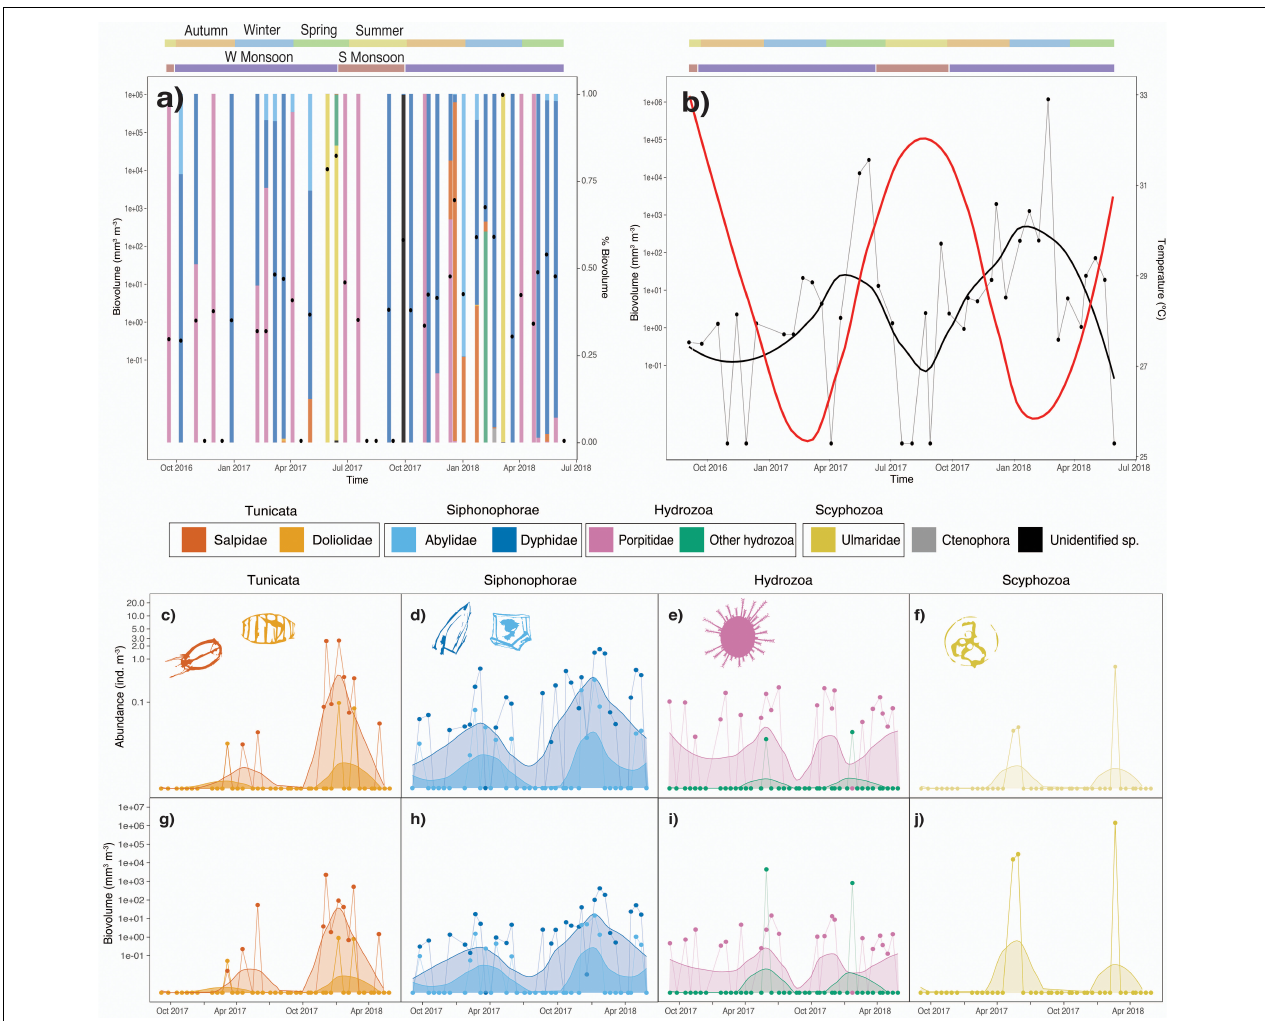
FIGURE 1 | Temporal variation in (a) biovolume of gelatinous zooplankton and% biovolume, (b) biovolume of gelatinous zooplankton and temperature, (c–f) abundance of the most important taxa, (g–j) biovolume of the most important taxa. Lines connecting points represent the real variation, while loess interpolation is presented to aid interpretation. Temporal interpolation was performed with loess (span = 0.45). Monsoon seasonality is shown accordingly to Patzert (1974) and Murray and Johns (1997). Temperate seasonality is shown for comparison.